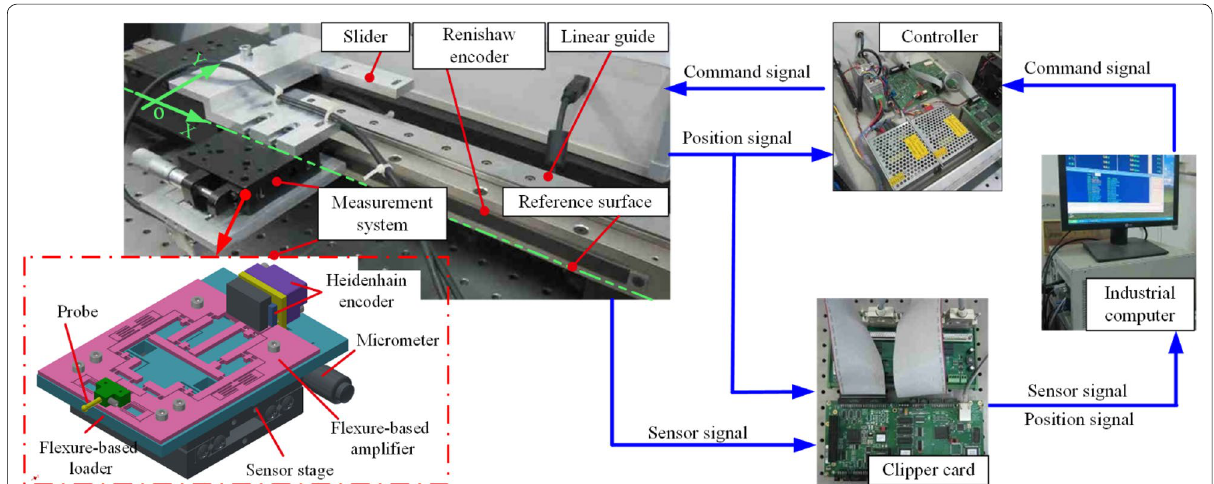
Figure 8 Schematic diagram of the experiment setup with a developed displacement sensor